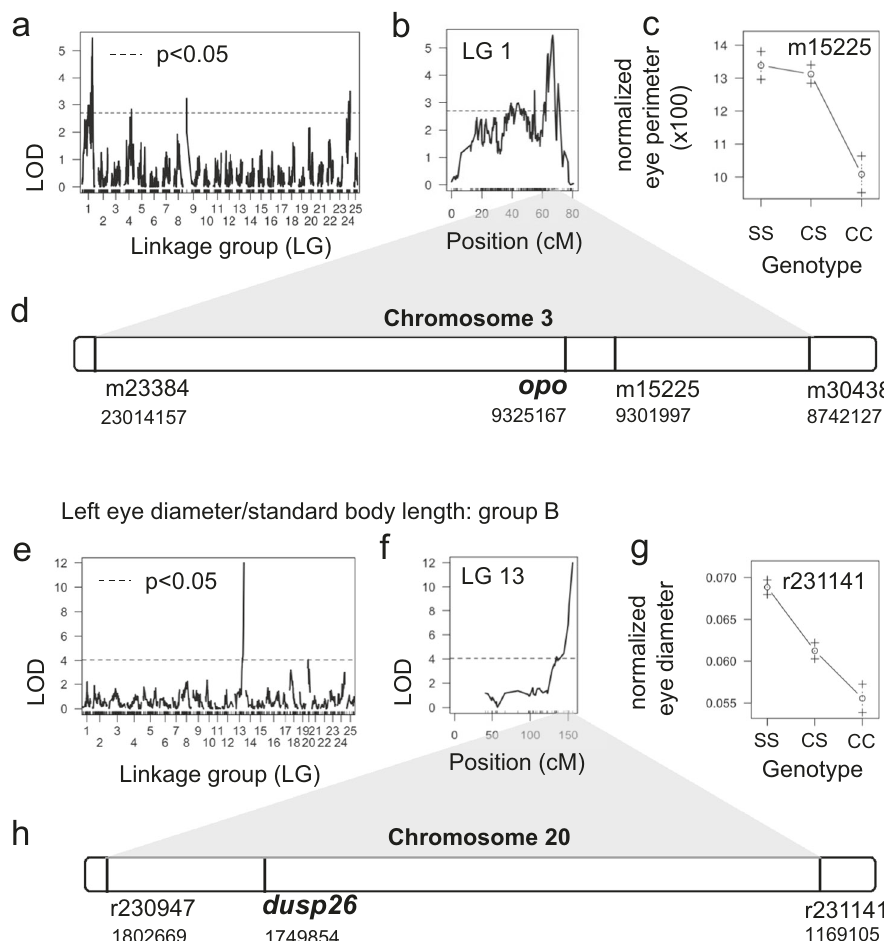
Fig. 3 Utilizing the surface fi sh genome for QTL mapping of eye size in surface/Pachón hybrids. Results from two independent mapping studies: group A ( a – d ) and group B ( e – h ). a , e Genome-wide LOD calculation for eye size using Haley – Knott regression and normal model. Signi fi cance threshold of 5% (black dotted line) determined by calculating the 95th percentile of genome-wide maximum penalized LOD score using 1000 random permutations. b , f LOD score for each marker on the linkage group with the peak marker. c , g Mean phenotype of the indicated genotype at the peak marker (S surface allele, C cave allele). d Relative position of the markers that de fi ne the 1.5-LOD support interval for group A on the surface fi sh chromosome 3. h Relative position of the markers that de fi ne the 1.5-LOD support interval for group B on chromosome 20 of the surface fi sh